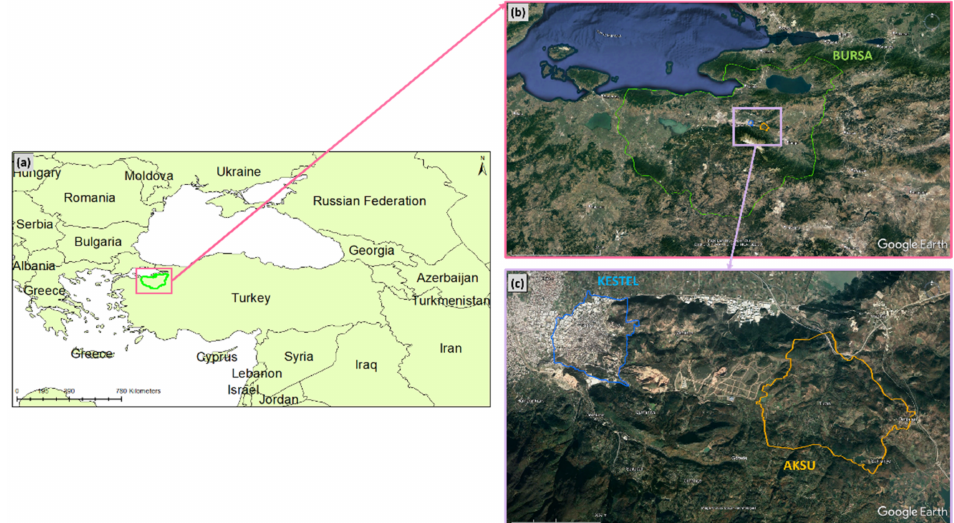
Figure 1. ( a ) General view of the study area and its surroundings. ( b ) The administrative boundary of Bursa province. ( c ) The administrative boundaries of Aksu and Kestel sites used in the